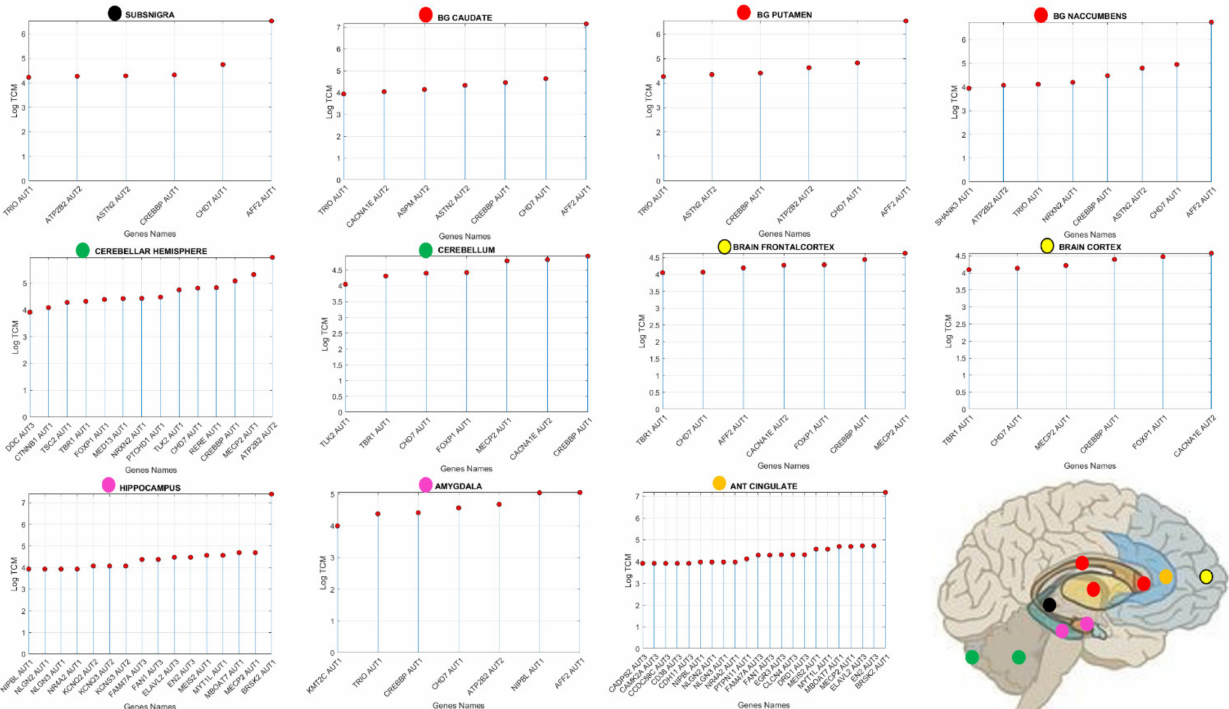
Figure 6. Common genes to Autism and all other neurological and neuropsychiatric disorders maximally express on brain tissues involved in the initiation, generation, control, coordination, and adaptation of movements, as well as in tissues necessary for the creation, retrieval and maintenance of memories and executive function. Genes’ expression is threshold above log(e 60 ) to show the top expressing genes from DisGenNet overlapping with those in the SFARI set (Full list of shared genes are in the Supplementary Materials Files.) The AUT# reflects the confidence score assigned to the gene at the SFARI repository. Horizontal axis shows the genes above threshold and vertical axis gives the expression level (log transcripts count per million, TCM.) Each colored dot is shown at the brain tissue in Figure 2A schematic